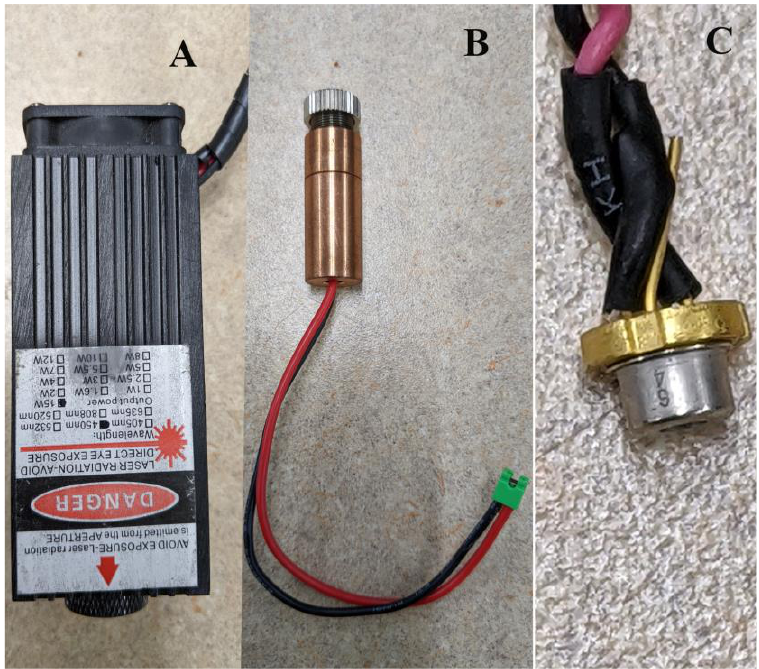
Figure 1. Diode lasers. ( A ) diode laser with heat sink enclosure including a fan, ( B ) diode laser without a cooling fan, and ( C ) exposed diode laser.